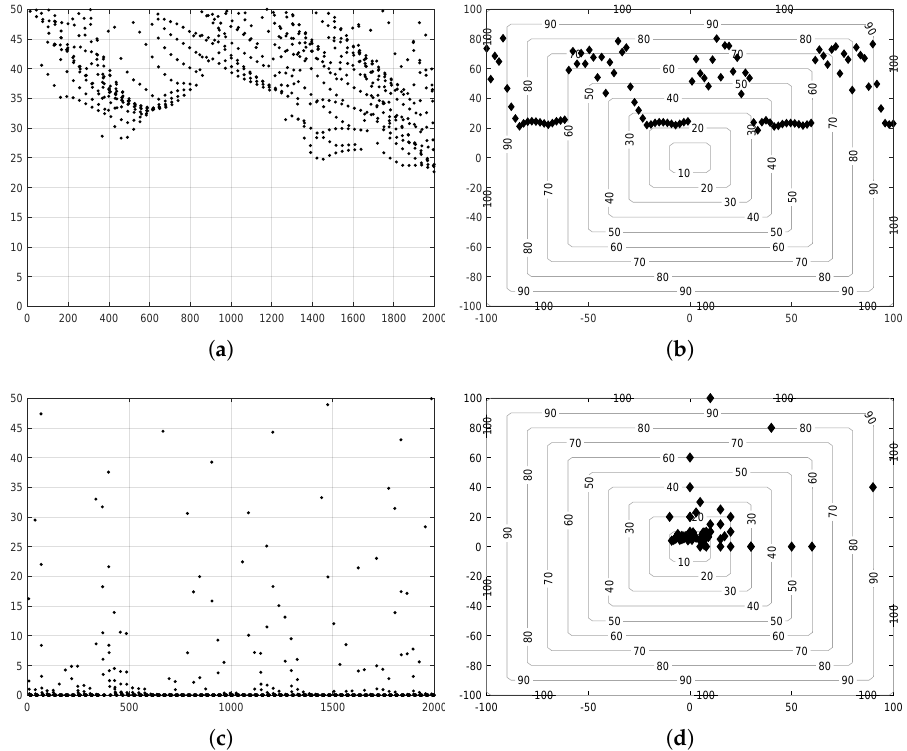
Figure 3. Average best solution (i.e., the achieved minimum, described by the y-axis) in terms of the number of objective function evaluations (x-axis) for the benchmark function f 4 using ( a ) SSA and ( c ) ISSA; corresponding convergence visualizations ( b , d ) in accordance with ( a , c ). ( b , d ) are the contour plots of the function f 4 , the x and y-axis represent the dimensions of the function, and the markers represent the evaluated points by running the optimization algorithms.